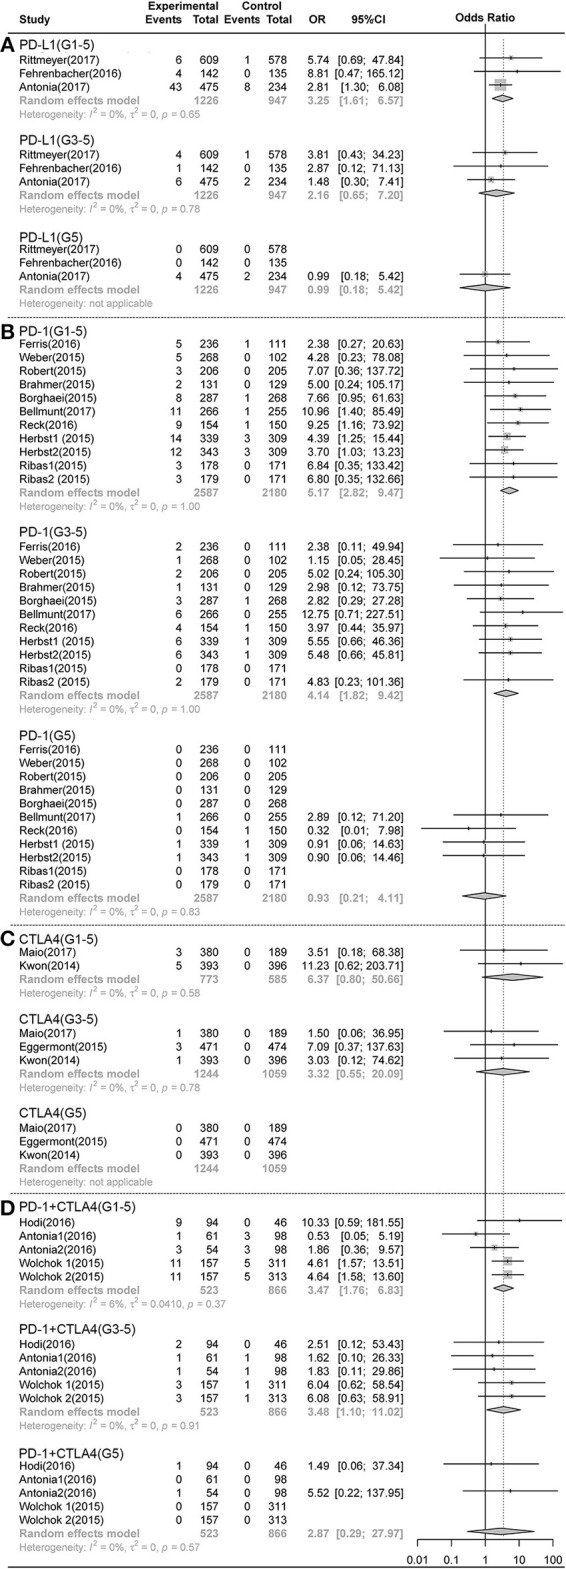
Forest plot analysis of pneumonitis comparing PD-1/PD-L1/CTLA4 with control therapies. (A) PD-L1 inhibitor V.S. chemotherapy/placebo; (B) PD-1 inhibitor V.S. chemotherapy; (C) CTLA4 inhibitor V.S. chemotherapy/placebo; (D) PD-1 combined CTLA4 V.S. ICI. G1-5, grade 1-5; G3-5, grade 3-5, G5, death.